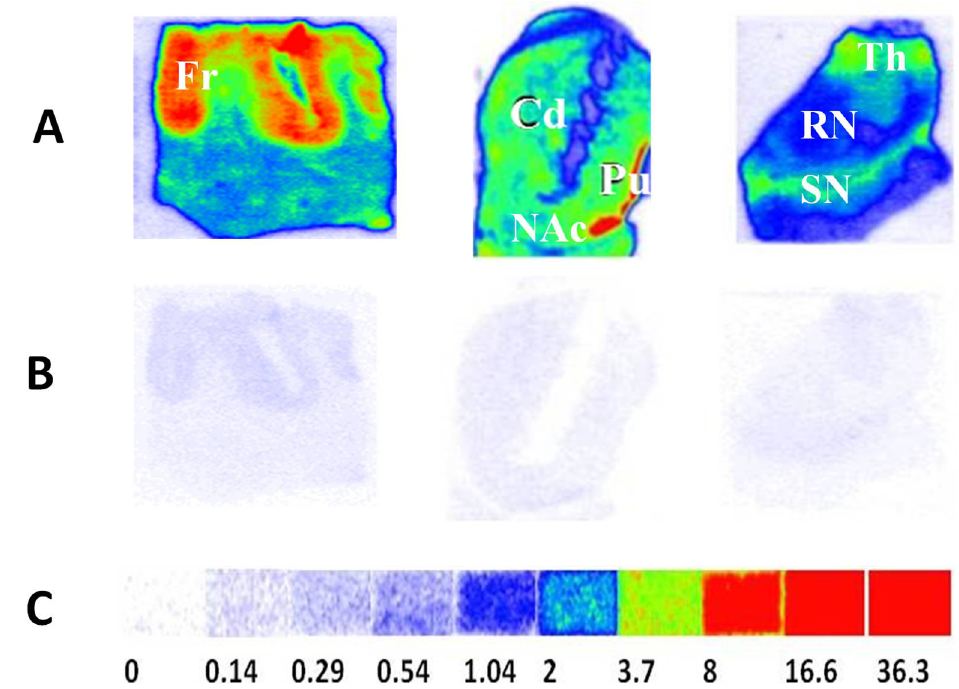
Figure 3. The striatal and extra-striatal TSPO distribution in the human brain. Autoradiograms show the total binding of 2 nM [ 3 H]PBR28 (panel A ) in the frontal cortex, striatum and substantia nigra regions of human brain sections. Nonspecific binding of the radiotracer was determined using adjacent tissue sections with 1 µ M PK11195 to mask TSPO (panel B ). [ 3 H]Microscale standards (ranging from 0 to 36.3 nCi/mg) were also counted for the calibration of radioactivity (panel C ). The following CNS anatomical regions are denoted: Frontal cortex (Fr); Putamen (Pu); Caudate (Cd); Nucleus accumbens (NAc); Thalamus (Th); Substantia nigra (SN); Red nucleus (RN). For autoradiograms: red indicates high, blue indicates medium and white indicates low binding activity. Adapted from Xu et al., 2019